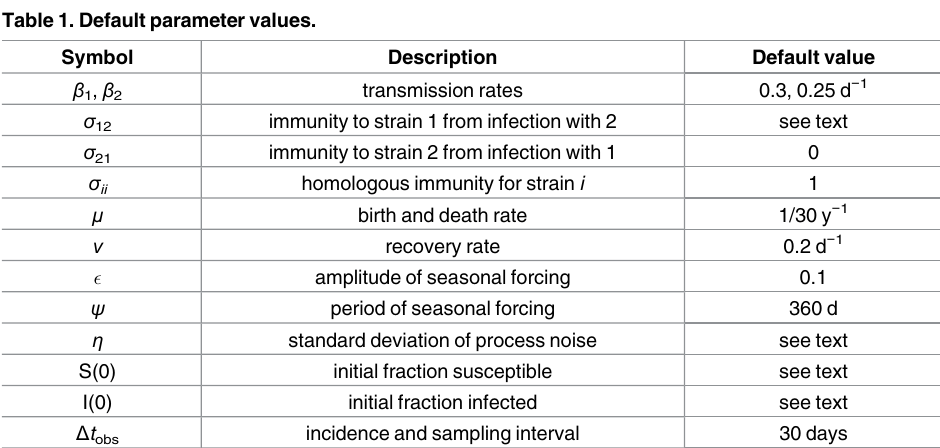
Table 1. Default parameter